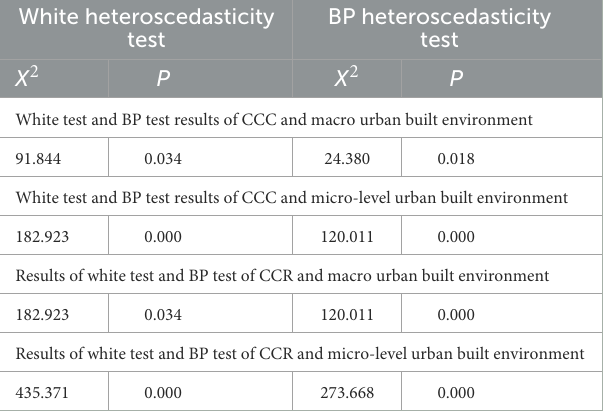
TABLE 3 Results of the white and BP tests. White heteroscedasticity